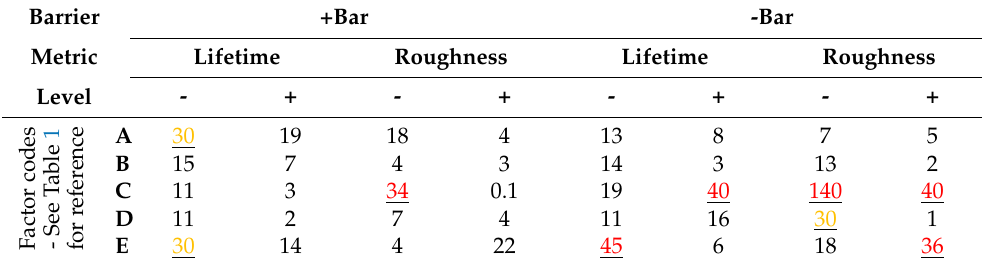
Red numbers are farthest from the CP, and yellows are marginally different.